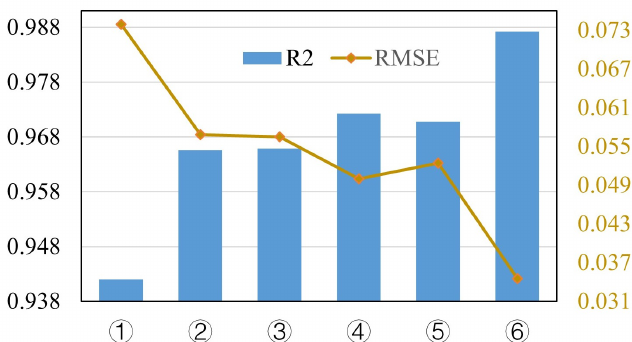
Figure 21. Average performance on two wells of the added modules.